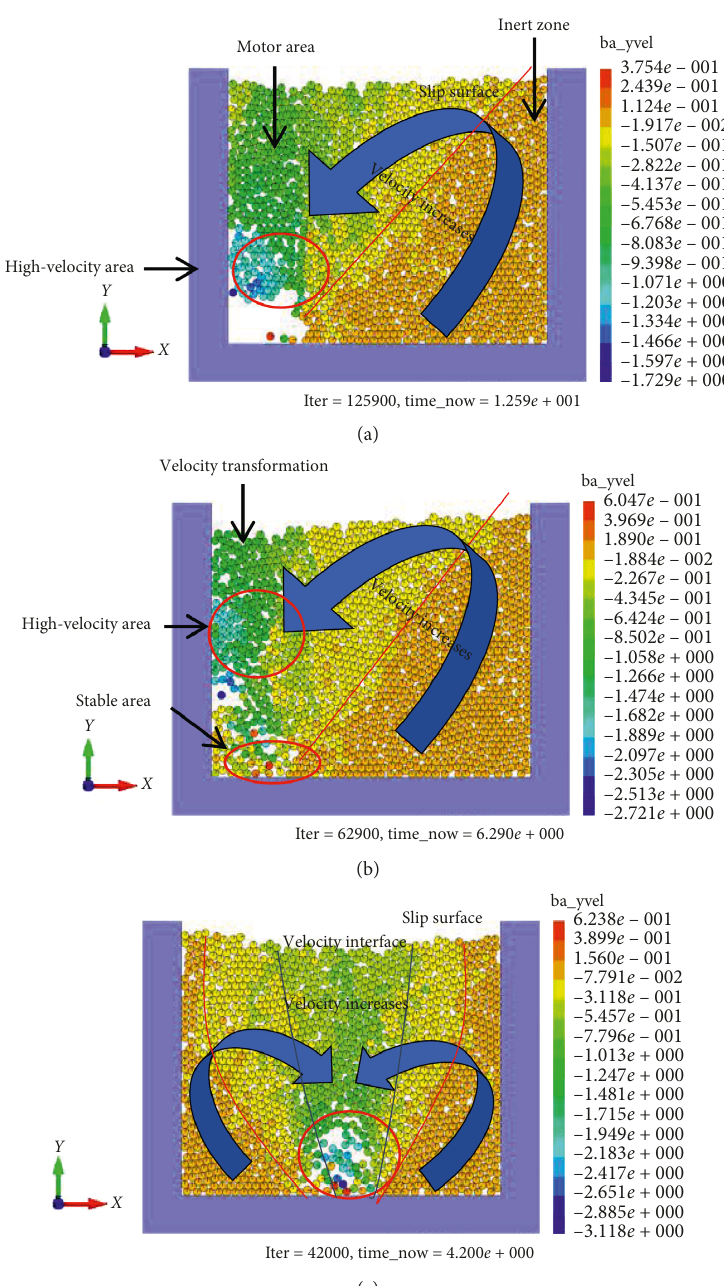
Figure 12: Change trend of velocity field of coal particle excavation. (a) Initial collapse of the lower left part of 0.1m coal particles. (b) The collapsing process of the lower left part of 0.1 m coal particles. (c) The collapsing process of the lower middle part of 0.1m coal